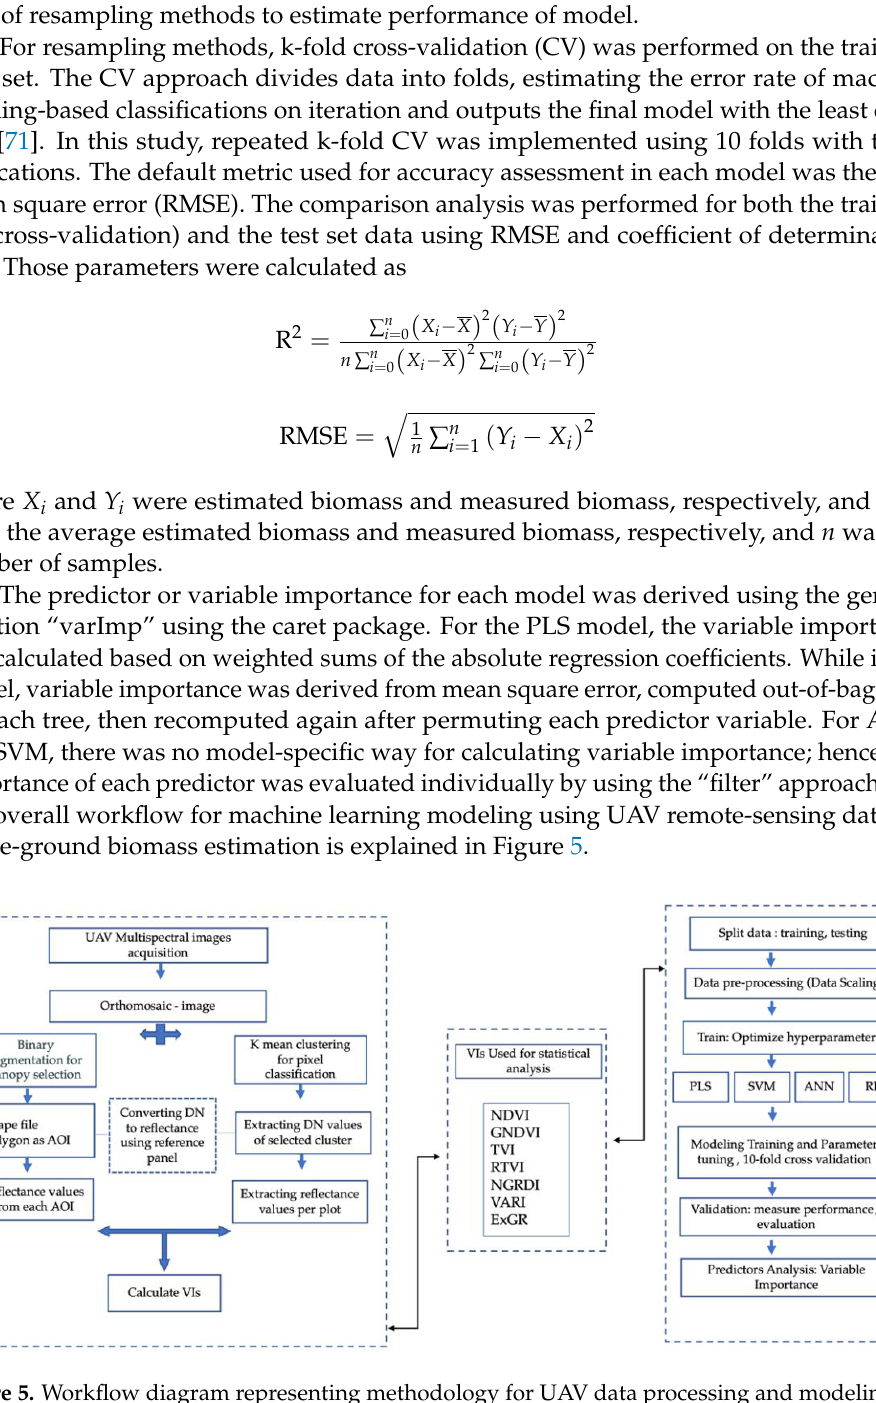
Figure 5. Workflow diagram representing methodology for UAV data processing and modeling for biomass estimation.